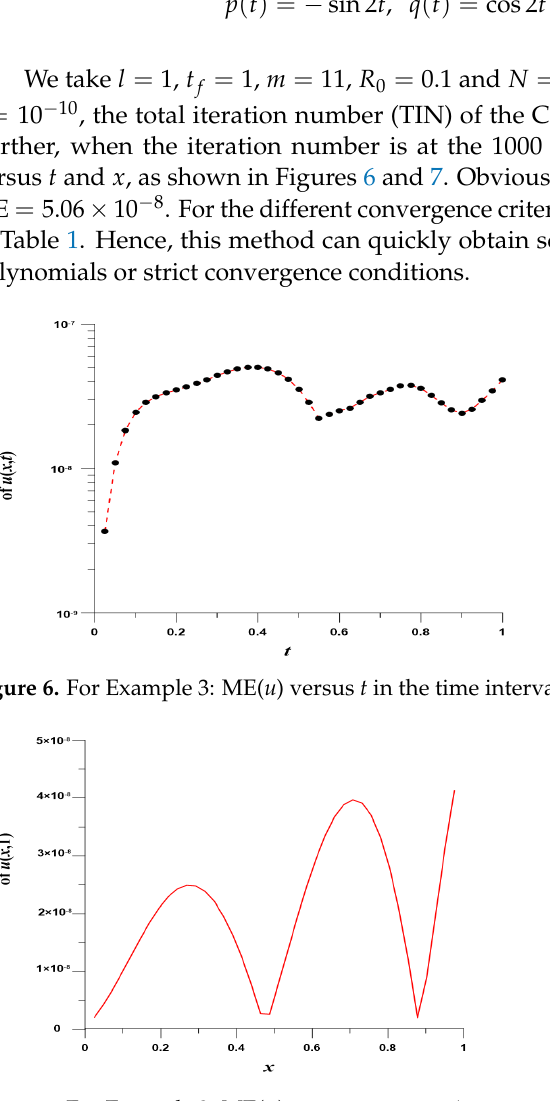
Figure 7. For Example 3: ME( u ) versus x at t f = 1. Table 1. The iteration number and ME under the different convergence